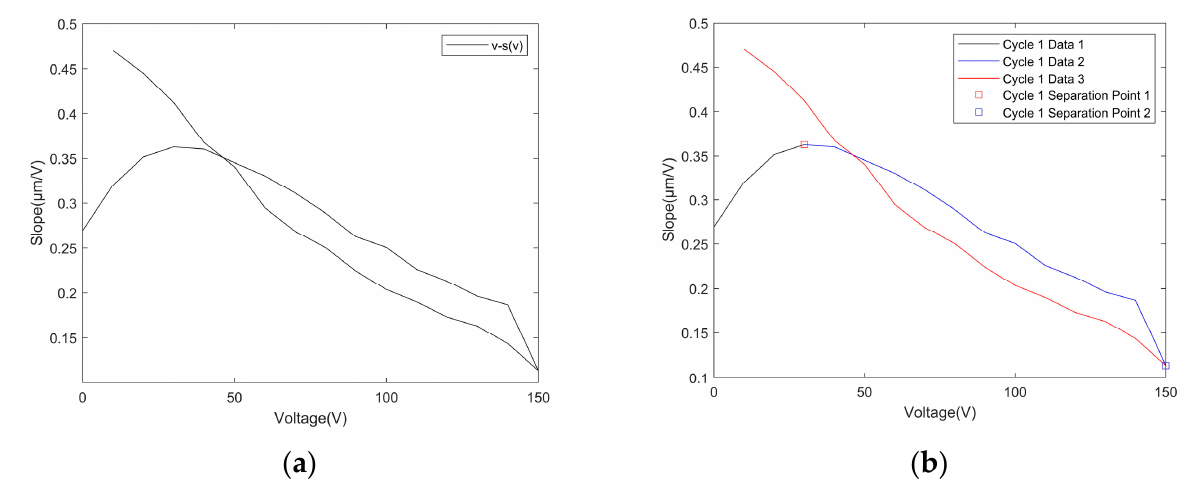
Figure 12. Voltage–hysteresis tangent slope plots: ( a ) cycle 1 v-s(v) plot; ( b ) cycle 1 slope data separation plot.